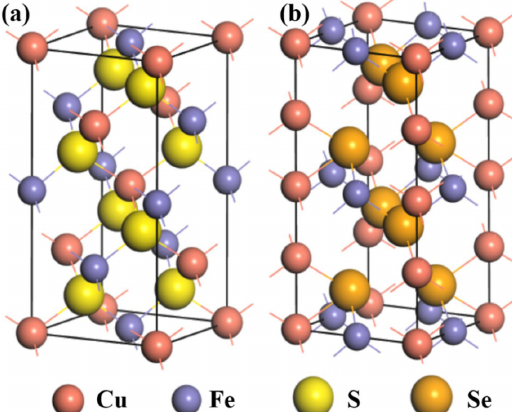
Figure 2. Schematic diagrams of crystal models of (a) CuFeS and (b) CuFeSe . 2